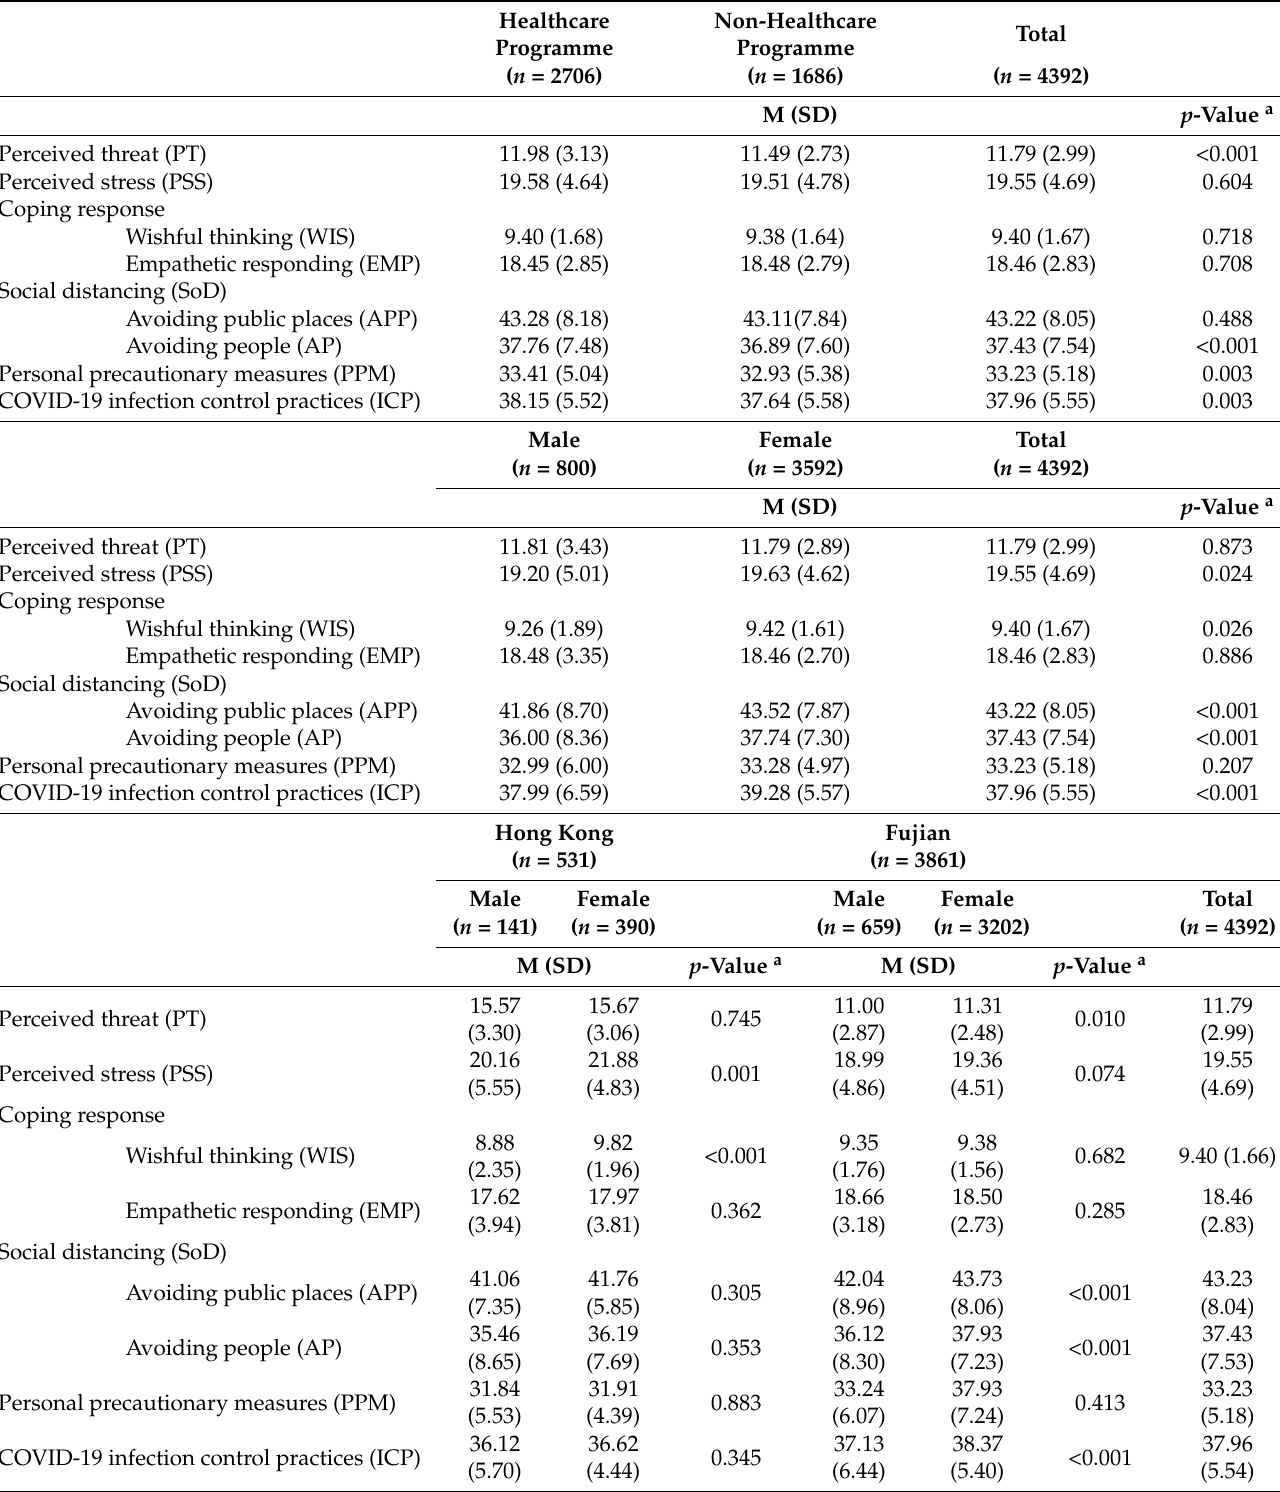
Table 2. Study variables by programme, gender, and by gender per geographical